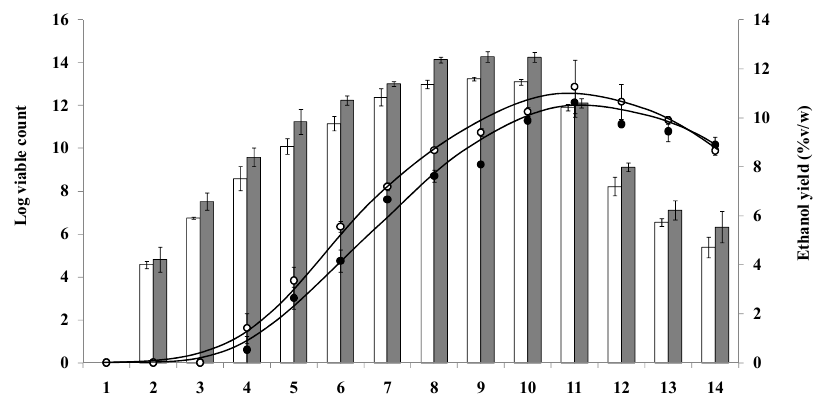
Figure 3. Viable count of free cells (bar) and fermentation efficiency (line) of two batches ( ■ , ● ) and three batches ( □ , ○ ) of yeast-gellan gum